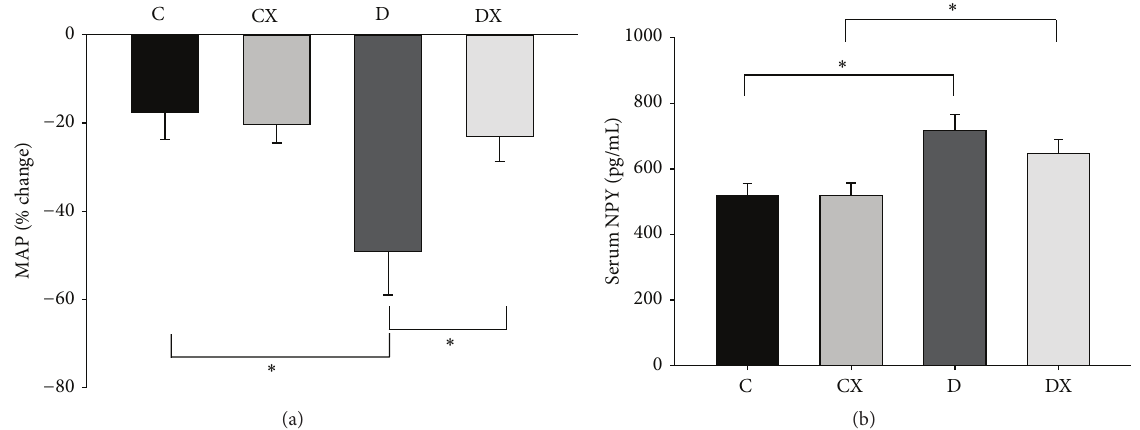
Figure 6: (a) Vascular sympathetic tone (VST) at week 10. This was determined by measuring the percent change in MAP after prazosin treatment at week 10: C, sedentary control ( 𝑛 = 8 ); CX, control exercise ( 𝑛 = 7 ); D, sedentary T1DM ( 𝑛 = 5 ); DX, T1DM exercise ( 𝑛 = 7 ). (b) Serum NPY at week 10: C ( 𝑛 = 6 ); CX ( 𝑛 = 6 ); D ( 𝑛 = 6 ); DX ( 𝑛 = 6 ). ∗ Significantly different groups ( 𝑝 < 0.05 ). Data are mean ±